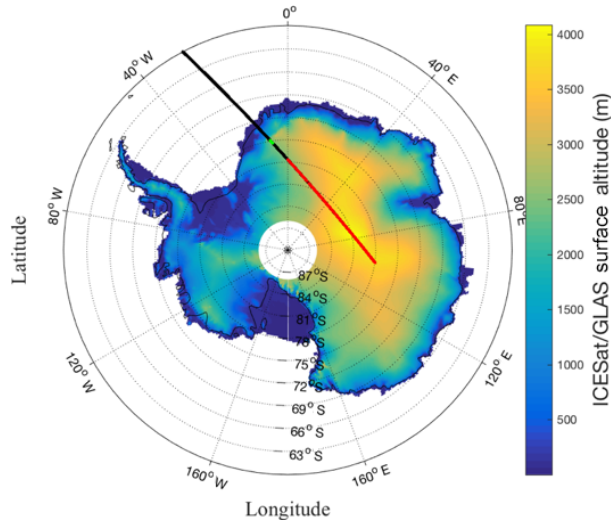
Figure 7. CALIOP ground-track over Antarctic (black line). Inter- mittent green lines show the unsaturated region and red lines show the saturated region of Fig. 6; the background color is the snow sur- face elevation (units of meters) from GLAS/ICESat Antarctic 500m DEM